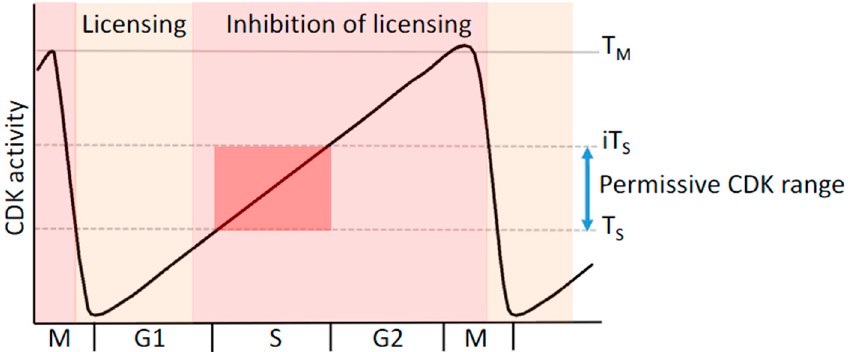
Figure 2. Quantitative model of CDK activity define cell cycle transitions. Cyclin ‐ CDK activity oscillates through the cell cycle defining key transition thresholds, threshold at S phase (T S ) and mitosis (T M ) that mark the G1/S transition and G2/M transition respectively. CDK activity also regulates temporal regulation of the replication licensing phase (cream) from the replication initiation phase (light red) where licensing is actively inhibited by high CDK activity. The permissive activity range for CDK activity for initiation of DNA replication (red) and at higher concentrations initiation is blocked until the subsequent cell cycle. The inhibitory concentration of CDK activity is denoted as iT S .